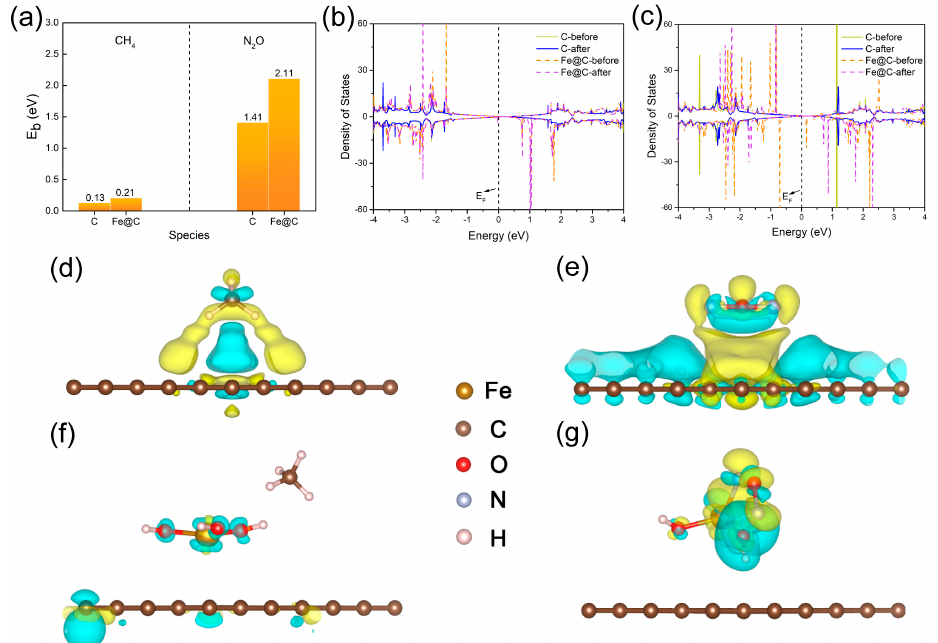
Figure 1. ( a ) Adsorption energies of CH 4 and N 2 O on different substrates. The density of states of ( b ) CH 4 and ( c ) N 2 O adsorbed on different substrates. The charge density difference for CH 4 − C ( d ), N 2 O − C ( e ), CH 4 -Fe@C ( f ), N 2 O − Fe@C ( g ). The isosurface is set to 4 × 10 − 5 e Å − 3 ( d , e ) and 4 × 10 − 3 e Å − 3 ( f , g ). Note that yellow and red are represented the charge accumulation and depletion.